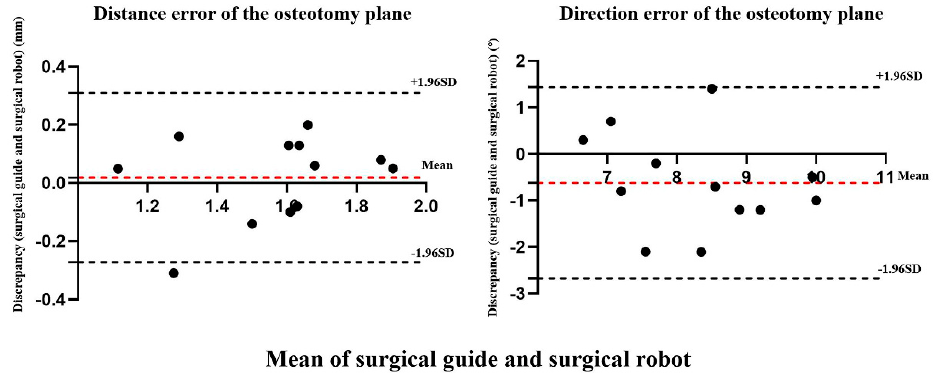
Figure 7. The Bland–Altman plot of distance error and direction error between the surgical guide and surgical robot.